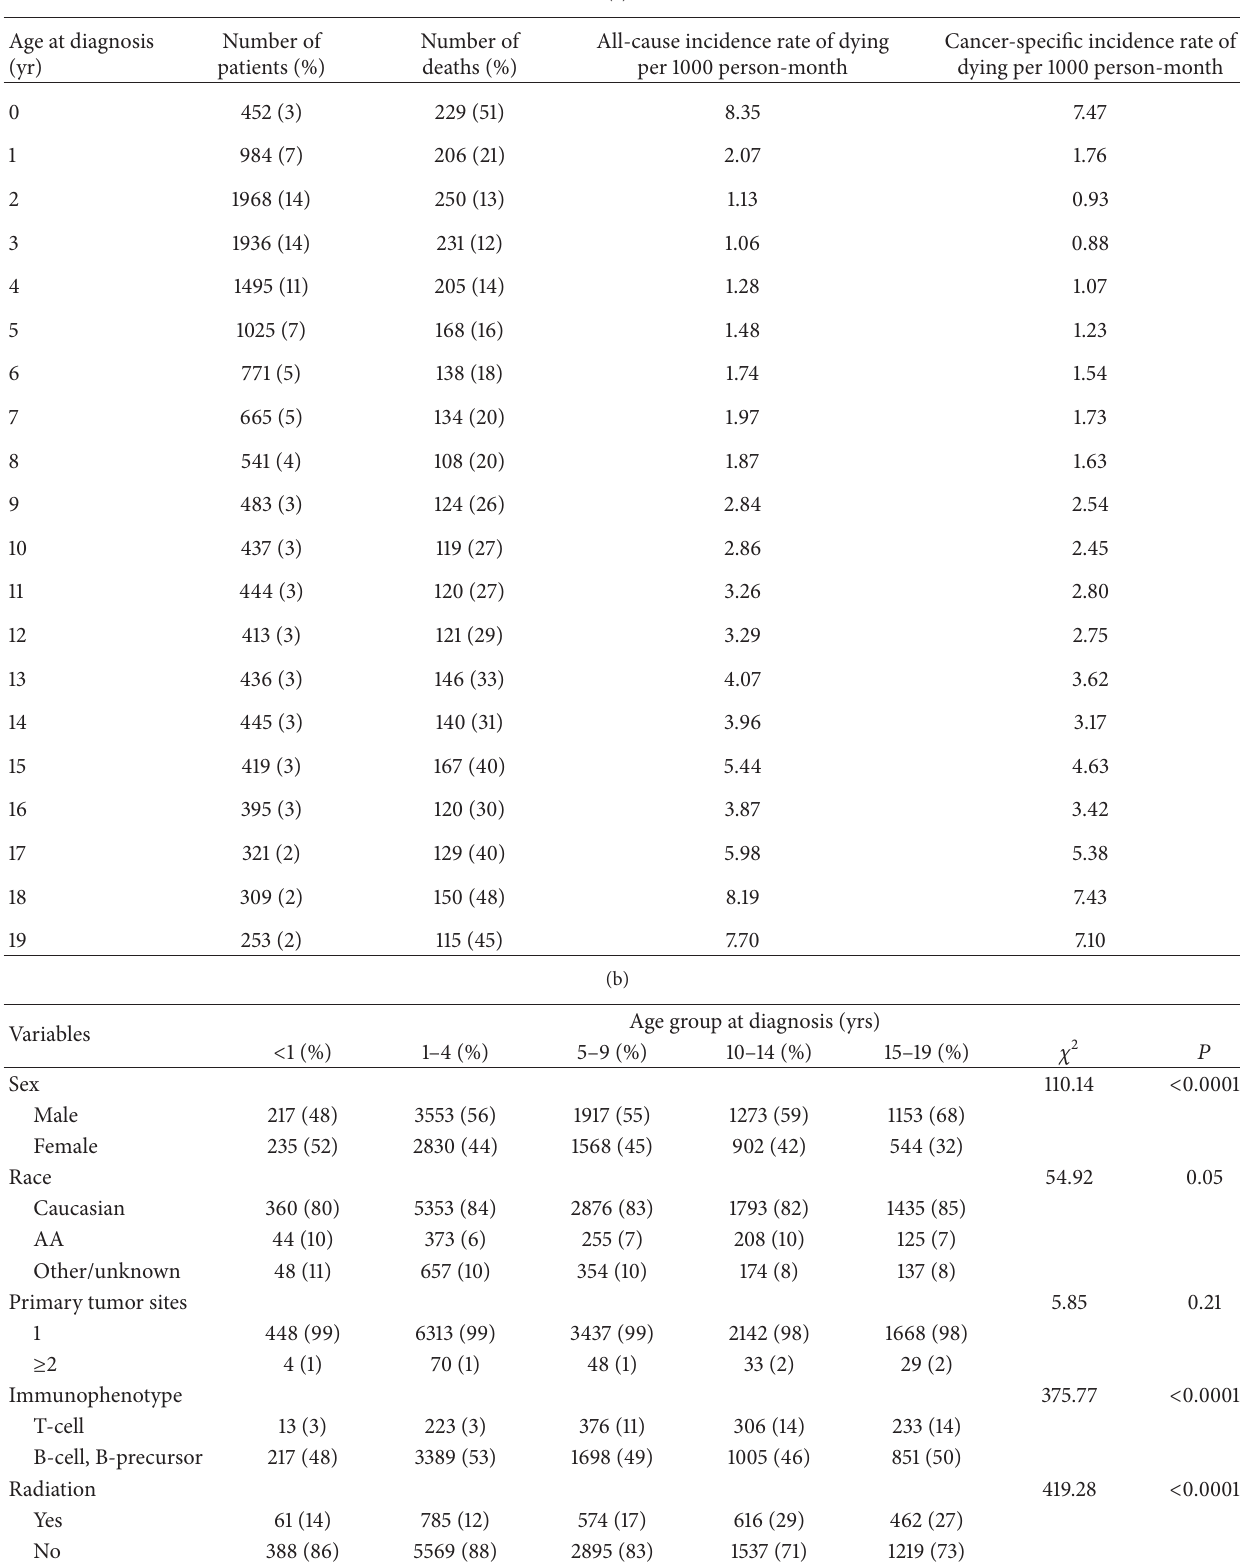
Table 1: (a) Risk of dying in ALL patients (1973–2009 SEER dataset) by age at diagnosis. (b) Characterization of pediatric ALL clinical features by age group at diagnosis, SEER dataset